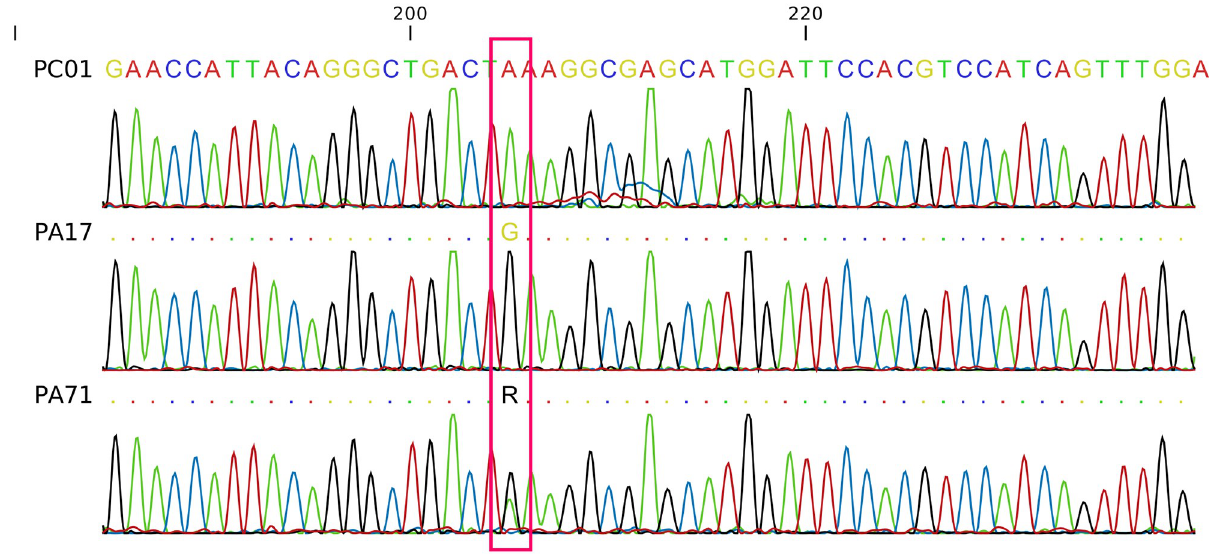
Fig 2. Electropherograms of the exon 2 of the SOD1 gene region harboring the c . 118G > A mutation associated with CDM. A pink rectangle is highlighting the SNP position. The first individual (PC01) is an AA homozygous Swiss Shepherd dog used as a reference. The second (PA17) is a GG homozygous individual, and the third is a AG heterozygous individual.